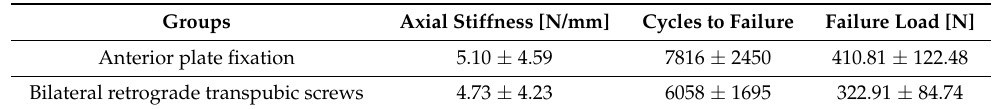
Table 1. Axial stiffness, cycles to failure and failure load in the study groups, presented in terms of mean value and standard deviation.